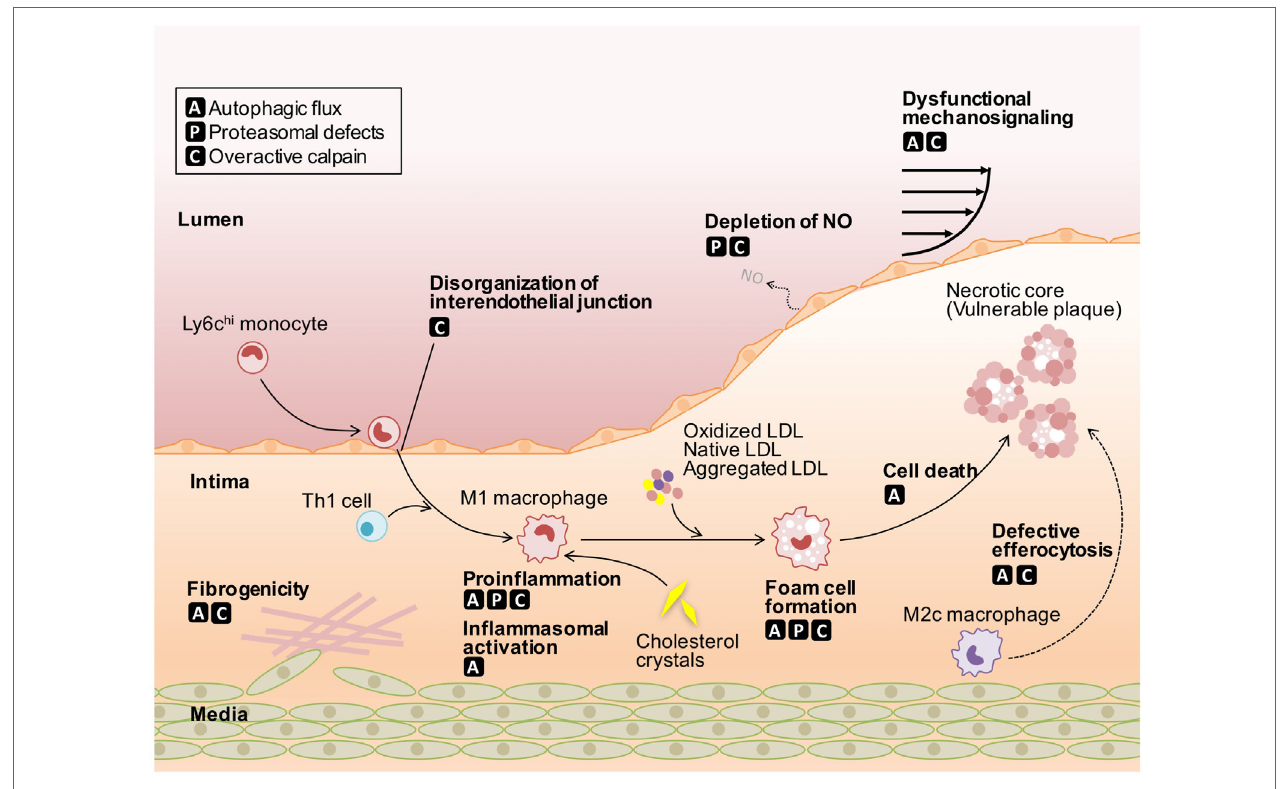
FiGURe 1 | Roles of defective protein catabolism in the pathogenesis of atherosclerosis. Autophagic flux leads to insufficient mechanosignaling in endothelial cells (ECs), impaired phenotypic conversion in vascular smooth muscle cells (VSMCs), proinflammatory actions in macrophages, and defective efferocytosis, thereby accelerating the onset of atherosclerosis. Proteasomal defects induce the depletion of nitric oxide in ECs and harmful proinflammatory responses in macrophages, despite protecting cells from apoptotic and non-apoptotic cell death. Overactivation of conventional calpains leads to impaired EC integrity, VSMC phenotypic conversion, and increased macrophage atherogenicity. Calpain-6 contributes to efferocytic pathways in macrophages. LDL, low-density lipoprotein; NO, nitric